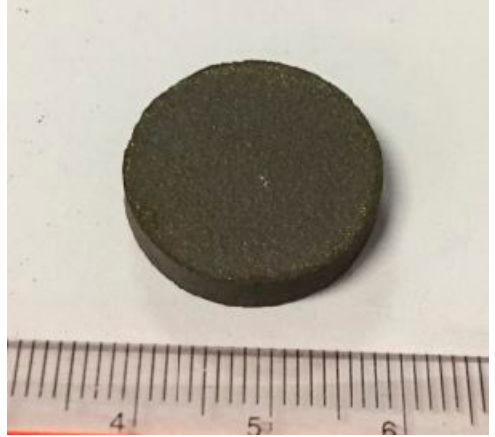
Figure 2. The composite powder cores prepared by SPS.